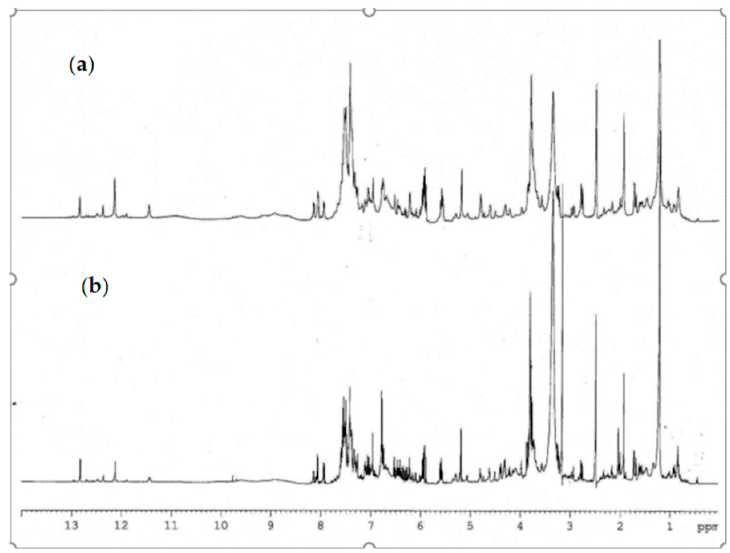
Figure 3. Comparison of 1 H-NMR spectra of propolis extract ( a ) plain sample ( b ) hill sample.